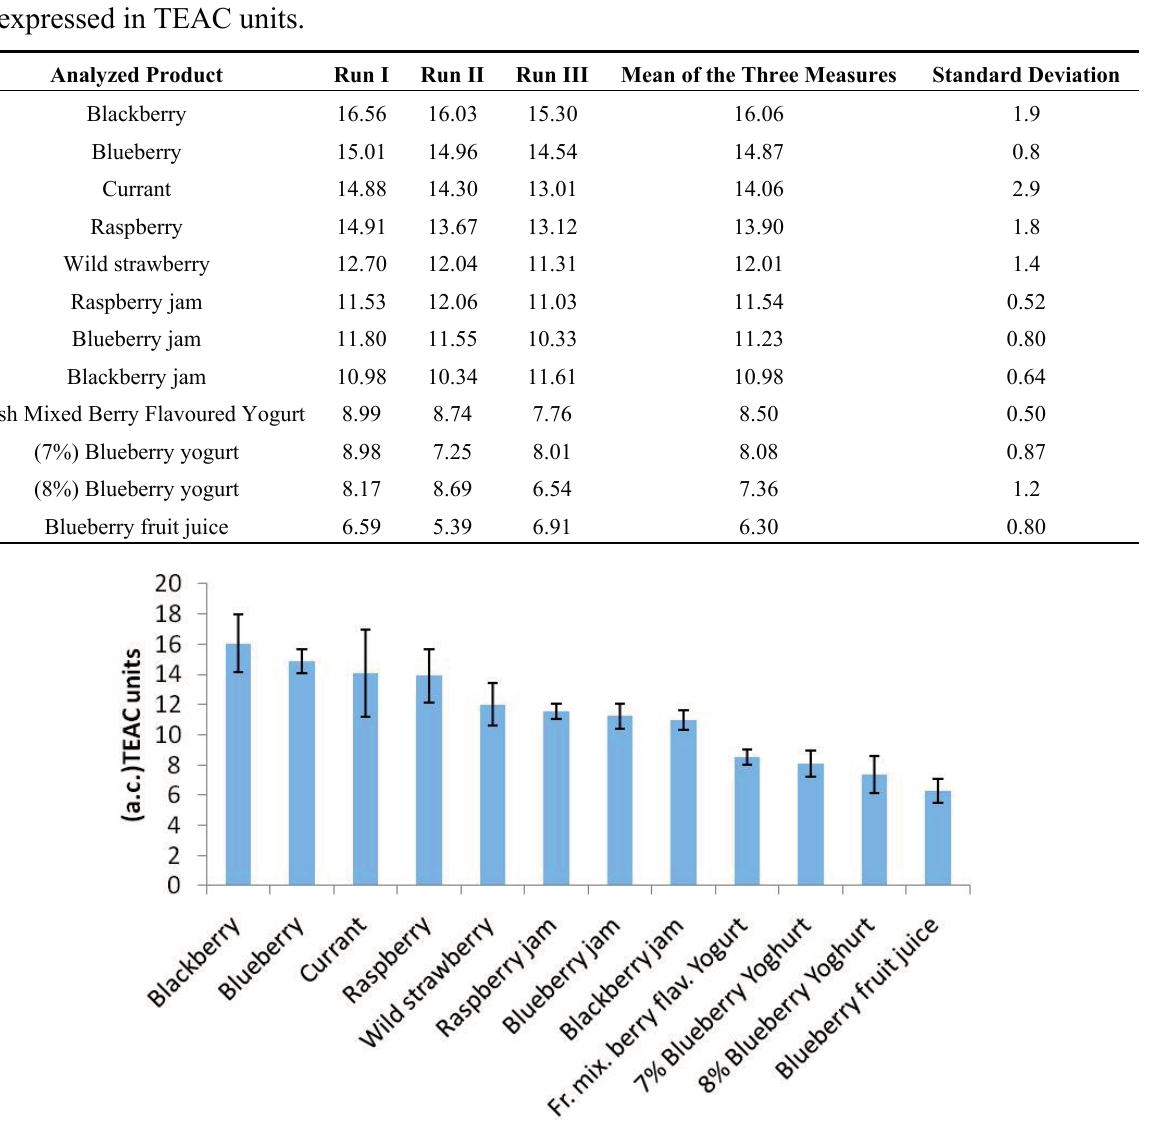
Figure 4. Histogram of antioxidant capacity values (a.c.), obtained using the spectrophotometric method. Results expressed in TEAC